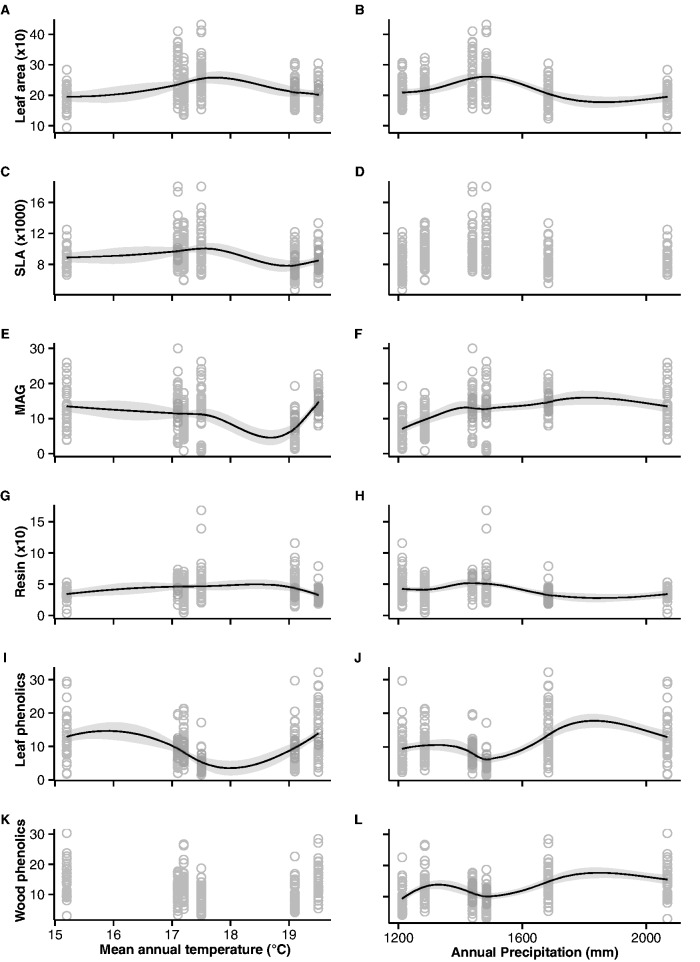
Relationship between leaf area (mm2; A and B), specific leaf area (SLA, mm2/g; C and D), mean annual growth (MAG, mm/year; E and F), resin (mg/g; G and H), needle phenolic content (mg/g; I and J) and wood phenolic content (mg/g; K and L) and climate (mean annual temperature and annual precipitation) of the six studied locations. Solid lines represent local polynomial regression fitting and grey shades are 95% confidence intervals. Panels D and K show no relationship between variables.